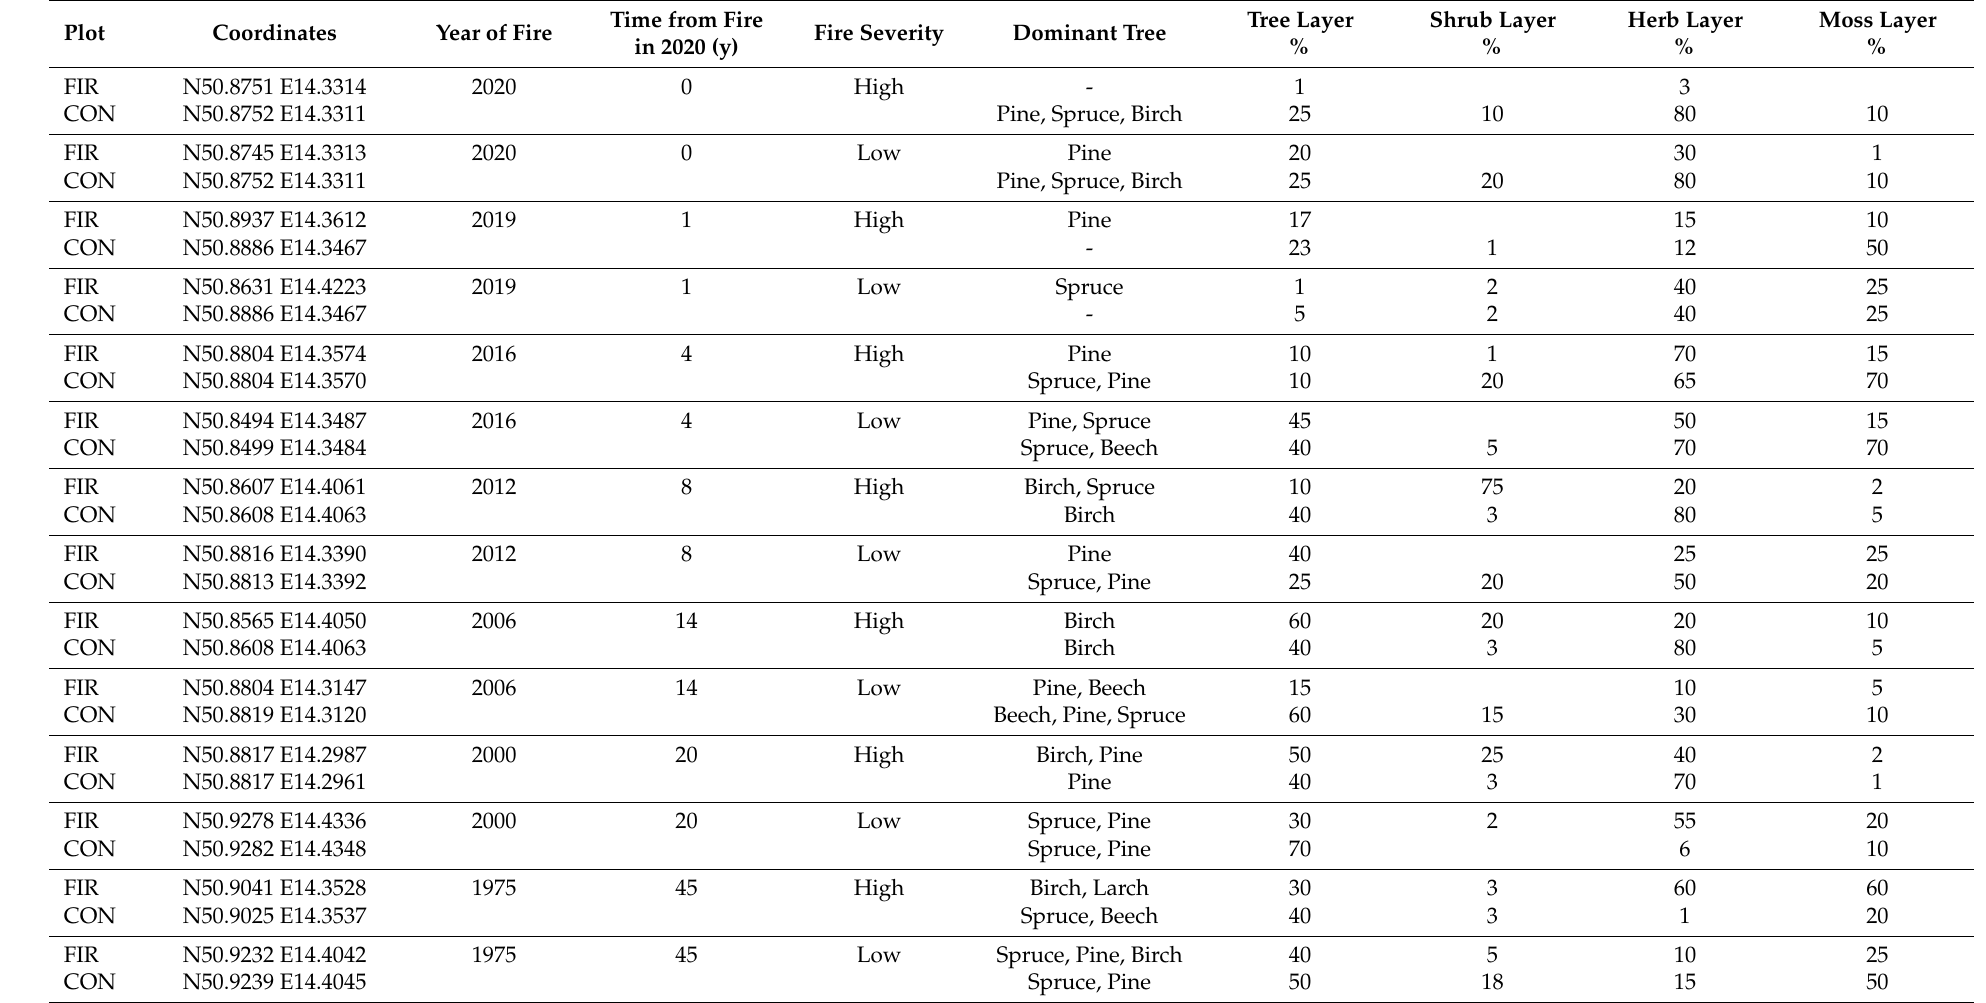
Table 1. Description of fire affected (FIR) and control (CON) plots of study